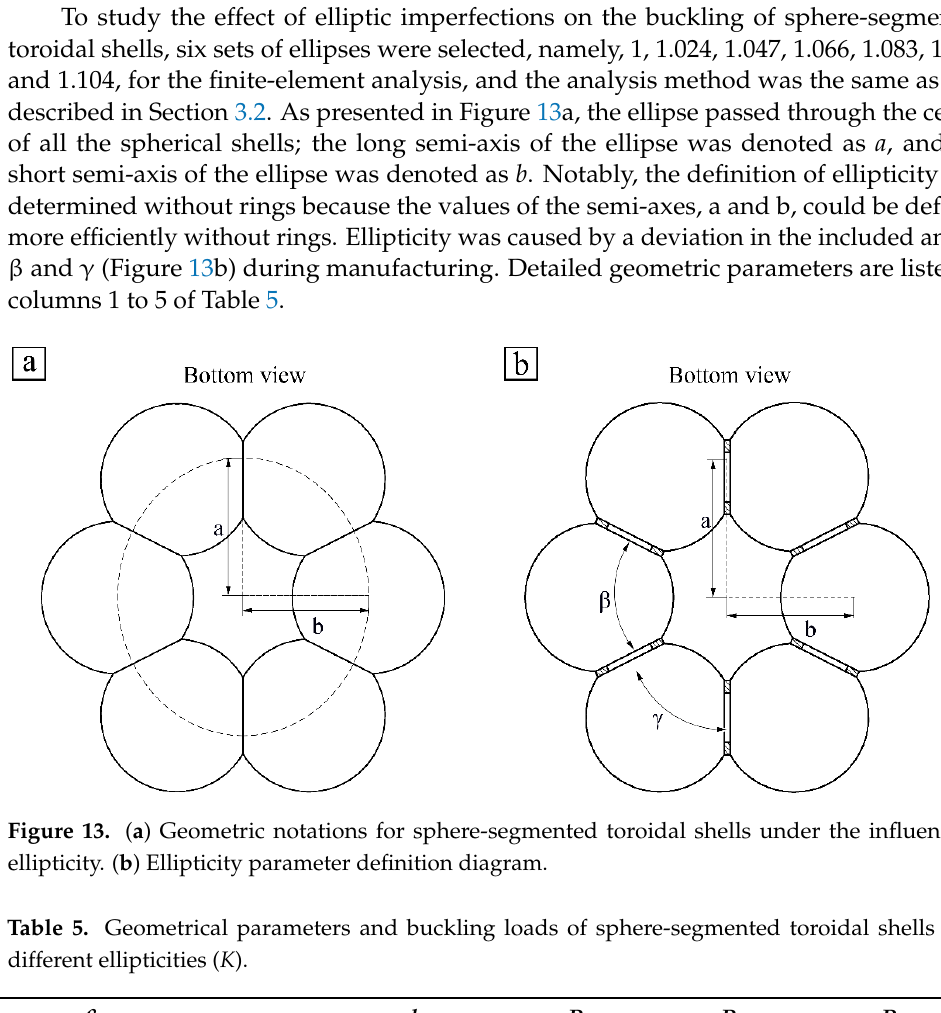
Table 5. Geometrical parameters and buckling loads of sphere-segmented toroidal shells with different ellipticities ( K ).